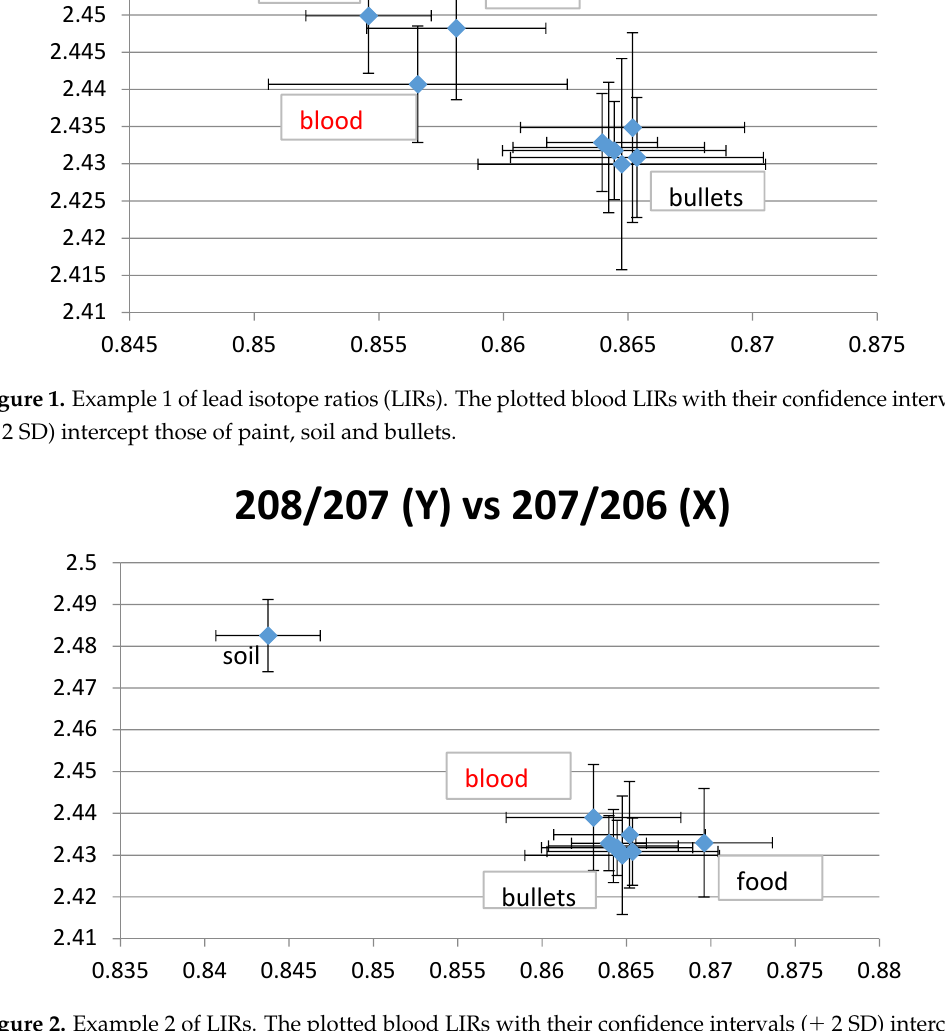
Figure 2. Example 2 of LIRs. The plotted blood LIRs with their confidence intervals ( ± 2 SD) intercept those of food and bullets but not soil.